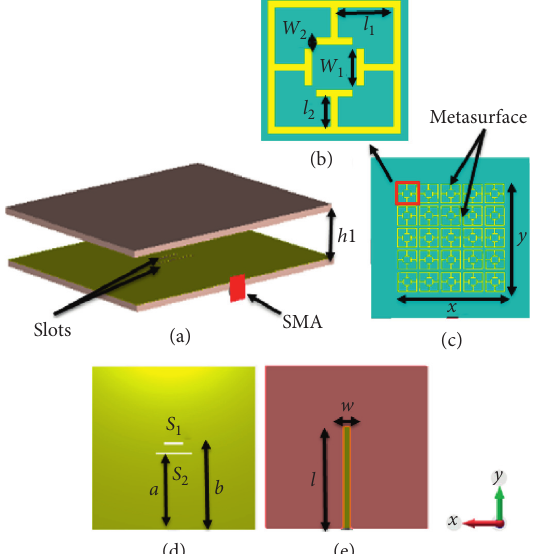
Figure 1: Schematic diagram of the proposed antenna (a), front view of a unit cell of the metasurface (b), metasurface layer (c), back view of the ground plane with slots (d), and front view with the microstrip line